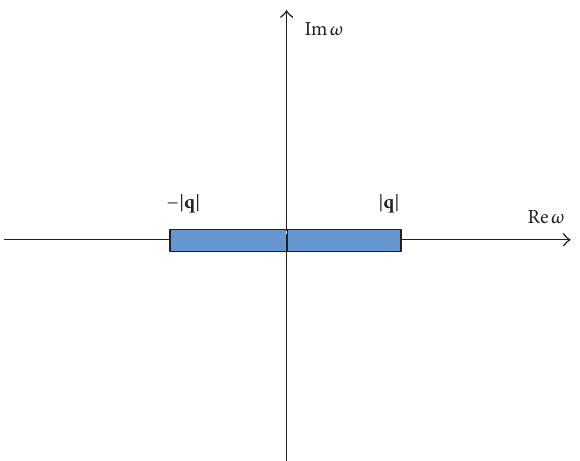
Figure 25: Transition temperatures for the quark-condensate, ⟨𝜓𝜓⟩(𝑇,𝜇 ) , and the PQCD threshold, 𝑠 𝑞 baryon chemical potential.